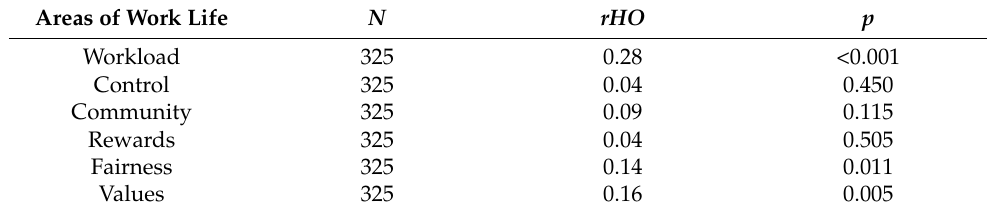
Table 3. Areas of work life and occupational burnout. Areas of Work